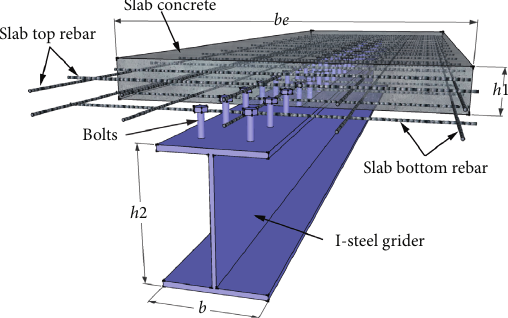
Figure 9: The schematic design of SCCBs. Table 2: Design parameters of